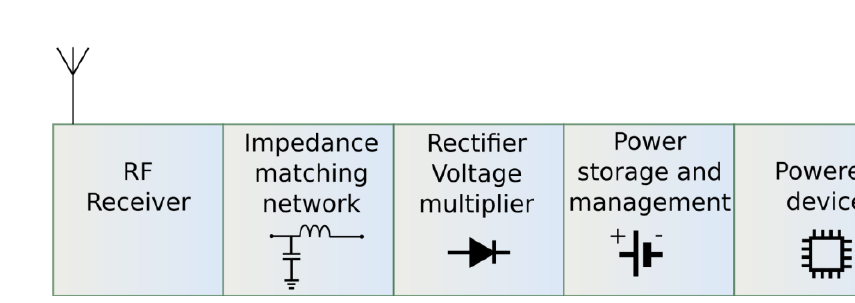
Energies 2023 , 16 , x FOR PEER REVIEW Figure 12. Block diagram of RF energy-harvesting system. Figure 12. Block diagram of RF energy-harvesting system.